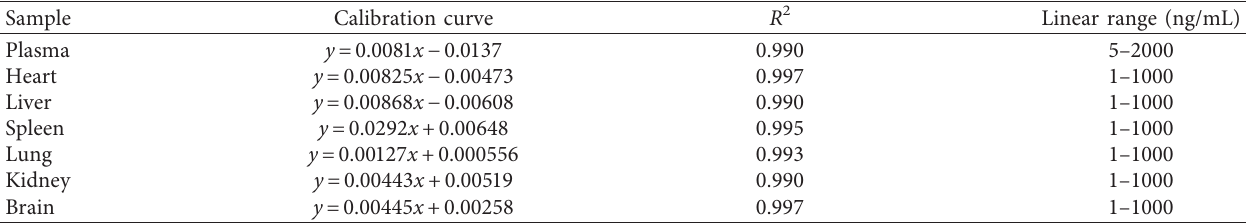
Table 1: Summary of LLOQ, linear ranges, regression equations, and correlation coefficients of analytes in rat plasma and tissue ho- mogenate